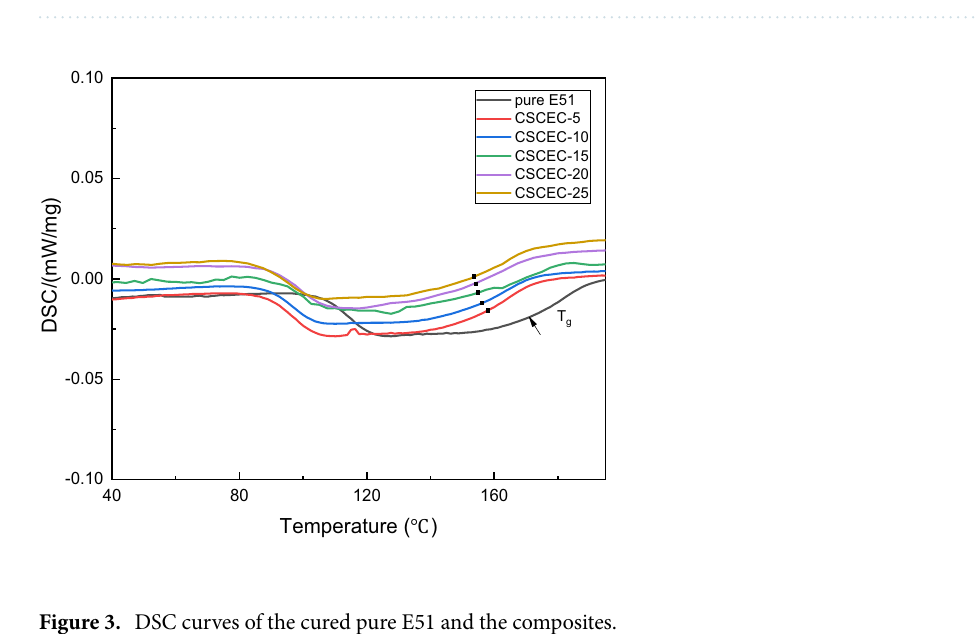
Figure 3. DSC curves of the cured pure E51 and the